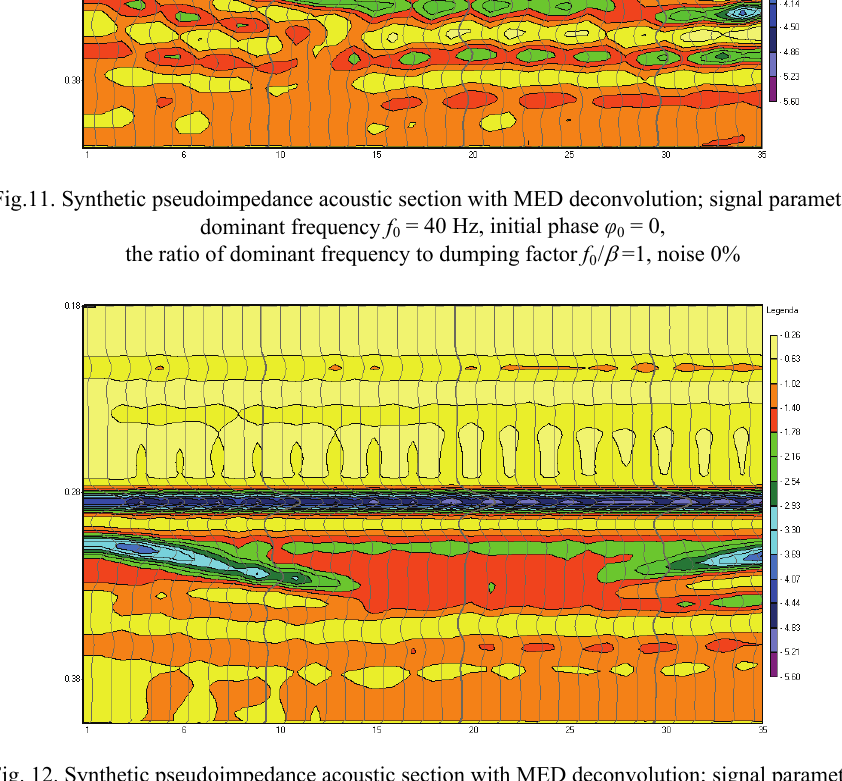
Fig. 12. Synthetic pseudoimpedance acoustic section with MED deconvolution; signal parameters: dominant frequency f 0 = 40 Hz, initial phase φ 0 = 0, the ratio of dominant frequency to dumping factor f 0 / β =2, noise